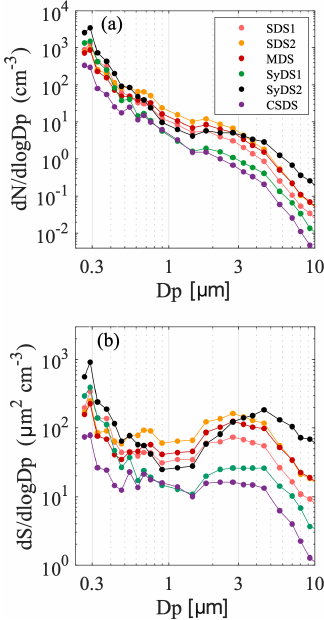
Figure 3. Particle size distributions. Particle number size (a) and surface area size (b) distributions averaged over the entire sampling periods of the events as monitored by GRIMM OPC during the stud- ied events. D p is the diameter of the particles and set at the center of each GRIMM